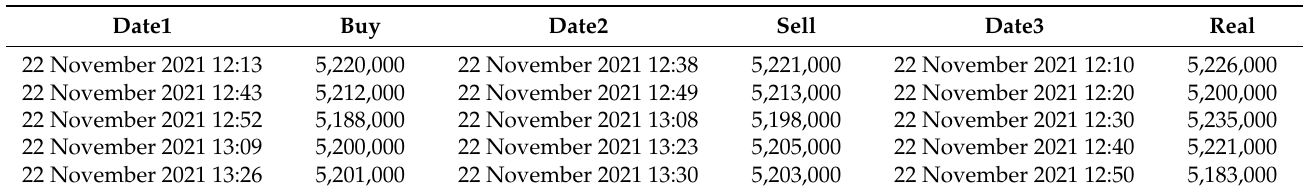
Table 2. Examples of the latest five accurate data per minute for Ethereum.